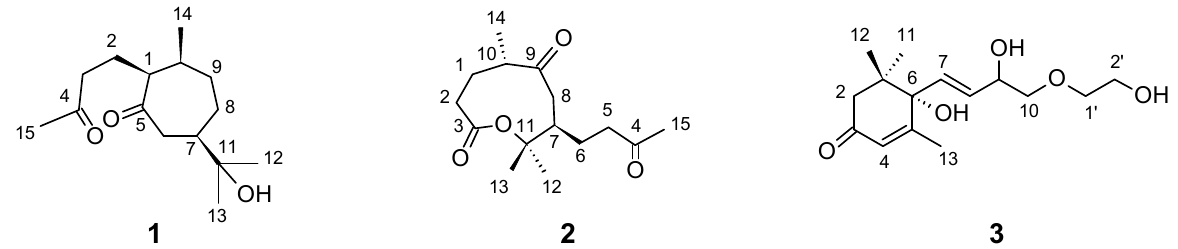
Figure 1. Chemical structures of compounds 1 – 3